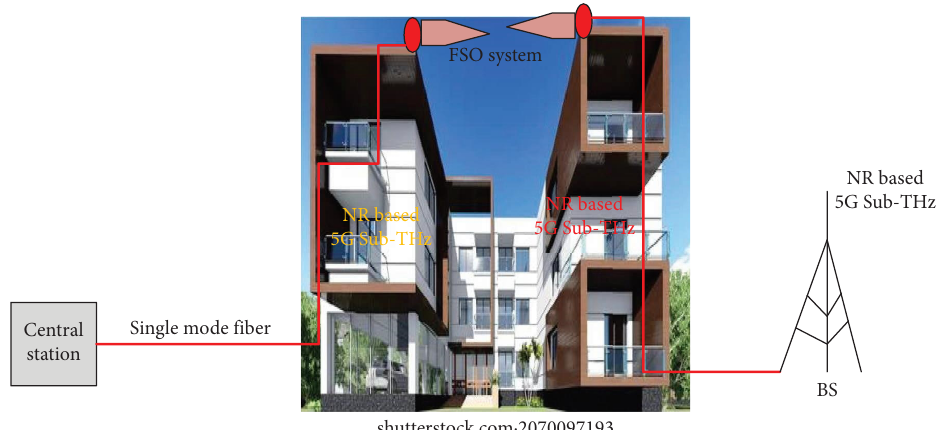
Figure 1: Mixed FSO and optical network based framework for addressing the FSO pointing and cochannel